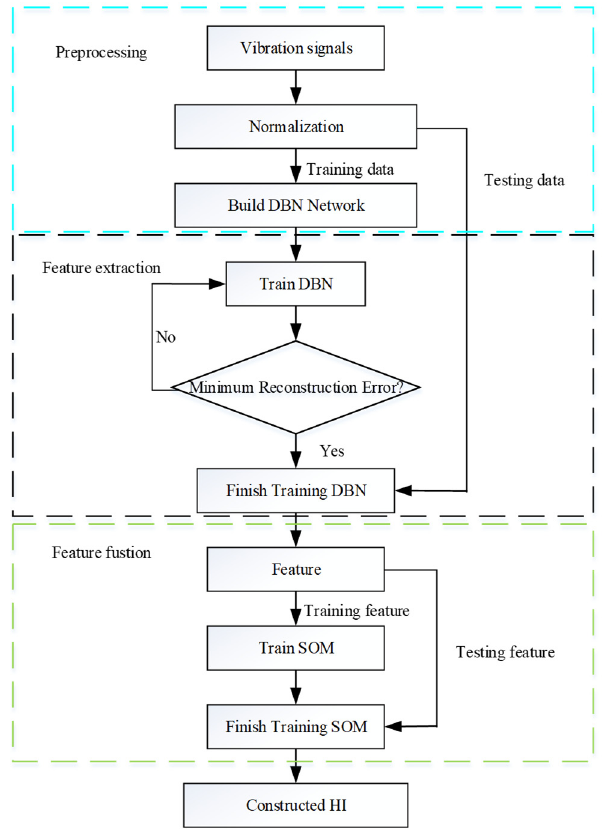
Figure 4. Flowchart of bearing health indicator construction.